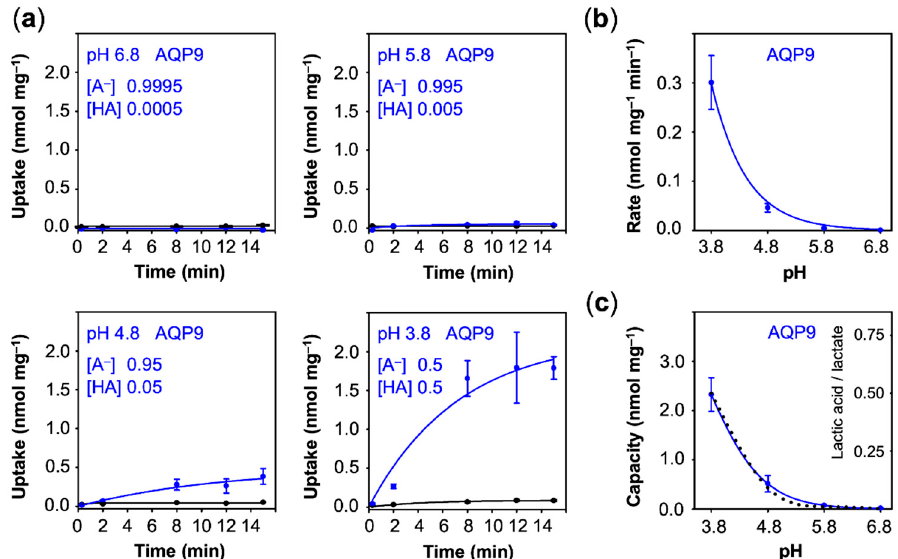
Figure 3. pH-dependent uptake of lactate/lactic acid into AQP9 expressing yeast. ( a ) Shown are uptake curves over time using cells with AQP9 (blue) compared to non-expressing cells (black). The proportion of external lactate anions [A – ] and neutral lactic acid [HA] is indicated for each pH condition. ( b ) Uptake rates derived from the uptake curves. ( c ) Uptake capacity obtained from the plateaus of the uptake curves. The dotted line indicates the proportion of neutral lactic acid at a given pH condition. Error bars indicate the standard error of the mean (SEM) from three independent experiments.